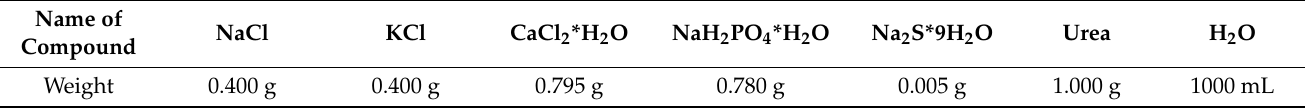
Table 2. Chemical composition of artificial